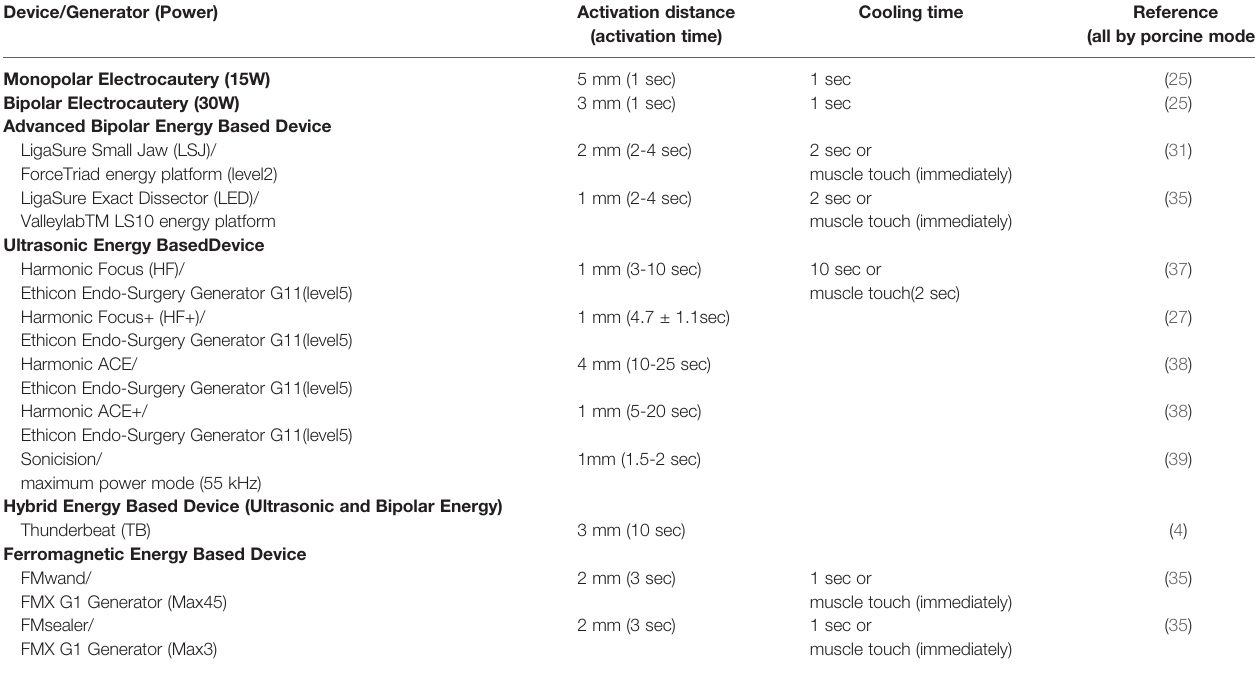
TABLE 1 | Summary of safety parameters of EBDs near the RLN during thyroid